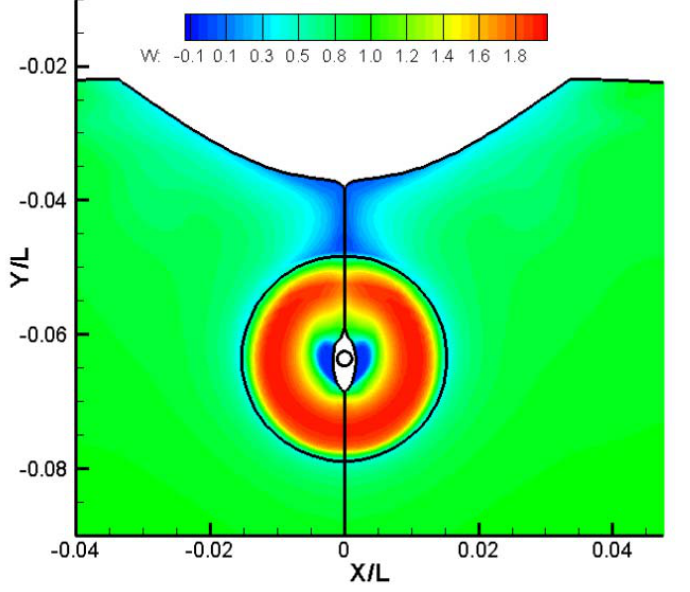
Figure 26. Axial velocity isowake curves on the propeller plane for a local maximum of the added resistance.